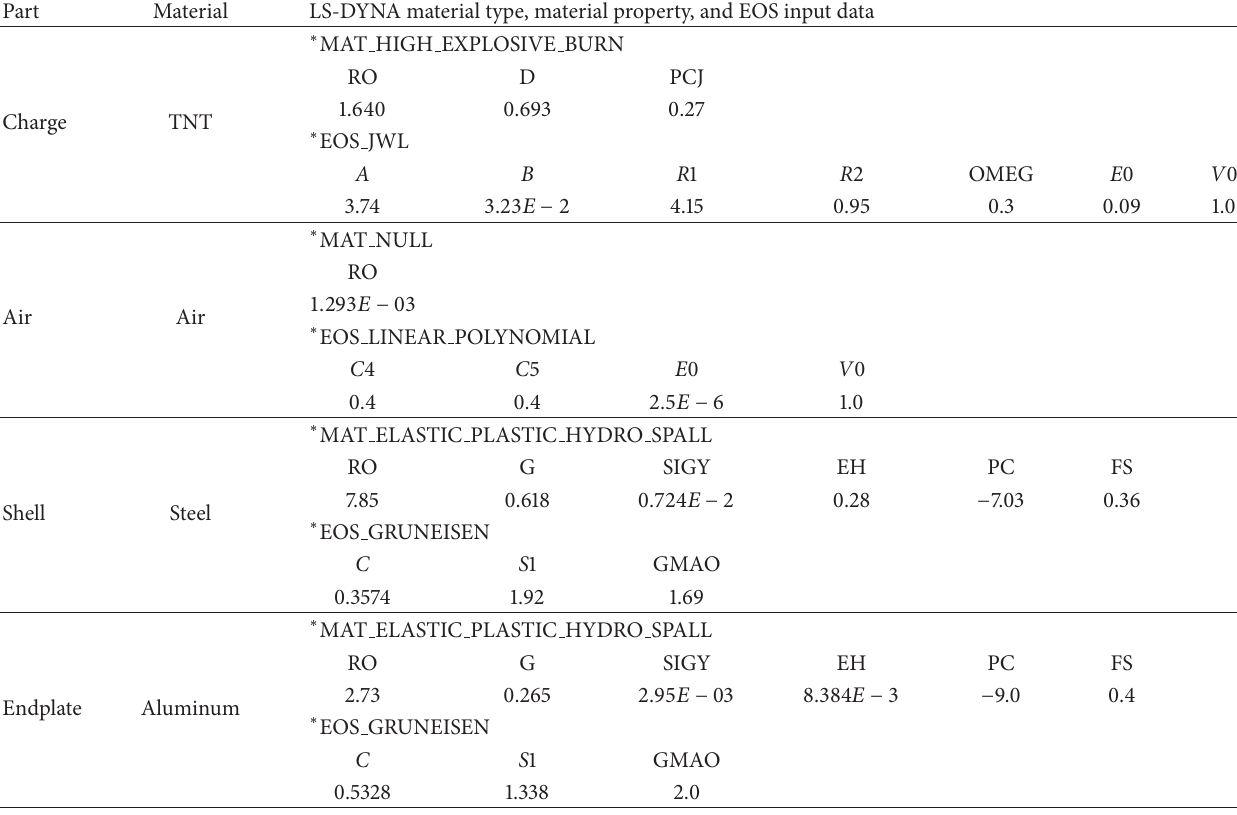
Table 4: Input data in the numerical simulation (unit = cm, g, and 𝜇